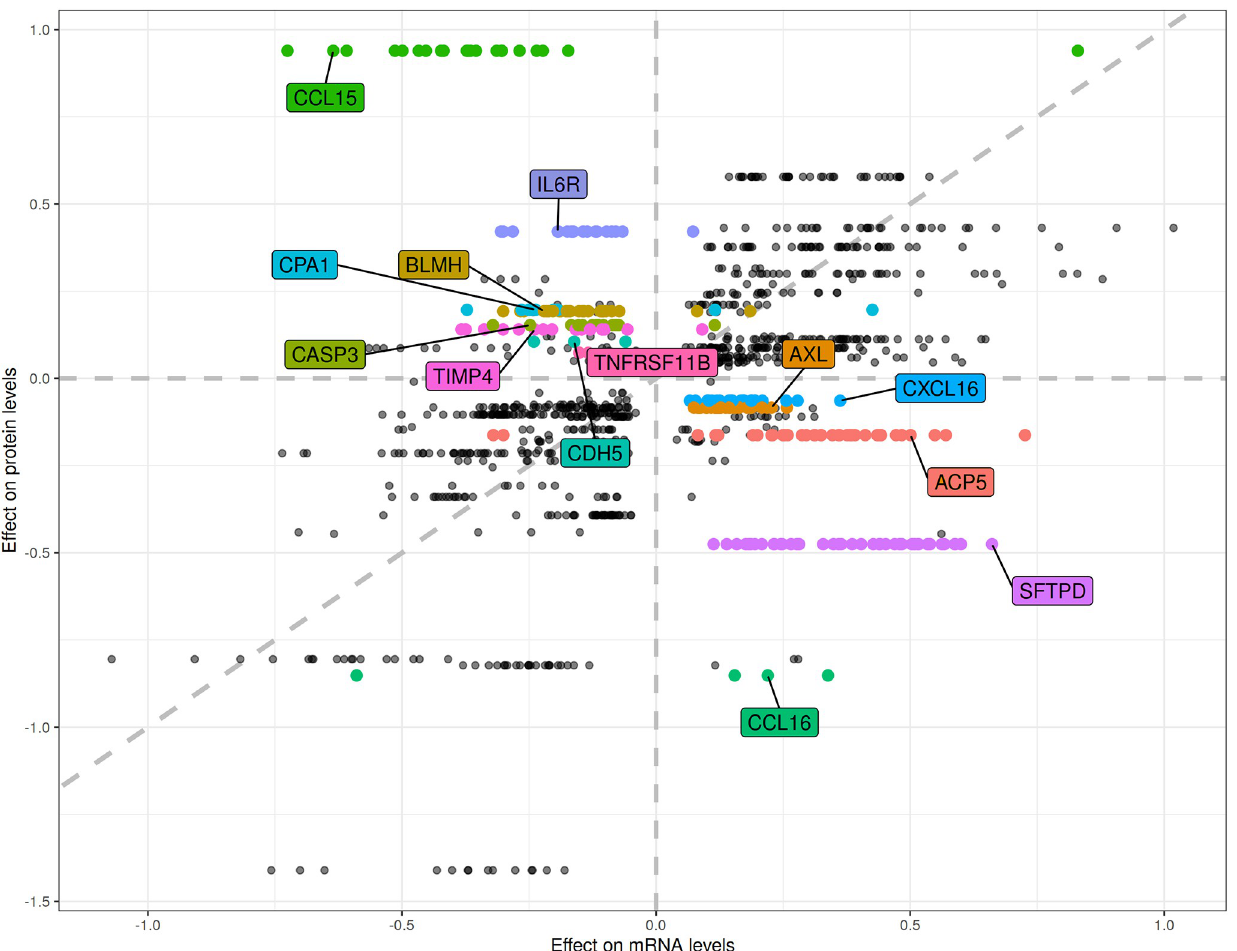
Fig 2. Scatter plot of effect estimates of the 63 lead pQTL-SNPs on gene expression and protein levels. As the focus was on the direction only, we did not normalize the effect estimates. Only SNPs with a significant eQTL in at least one tissue are displayed (p < = 0.05 in GTEx). Results of the 13 genes showing discordant pQTL and eQTL directions in more than 75% of eQTL tissues are labeled (see also Table 2 and S5 Table in S2 File).